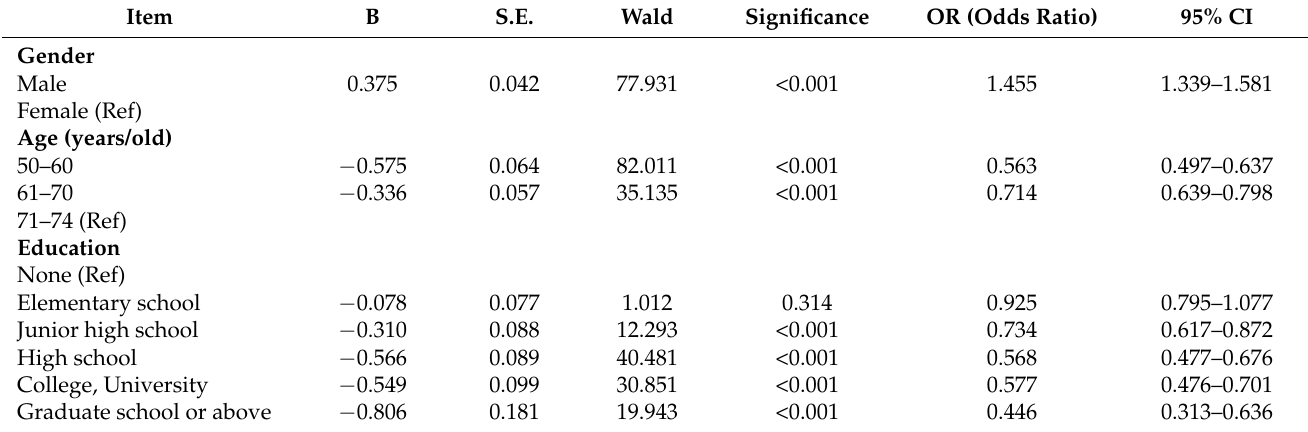
Table 5. Logistic regression analysis of the basic data of tested participants.